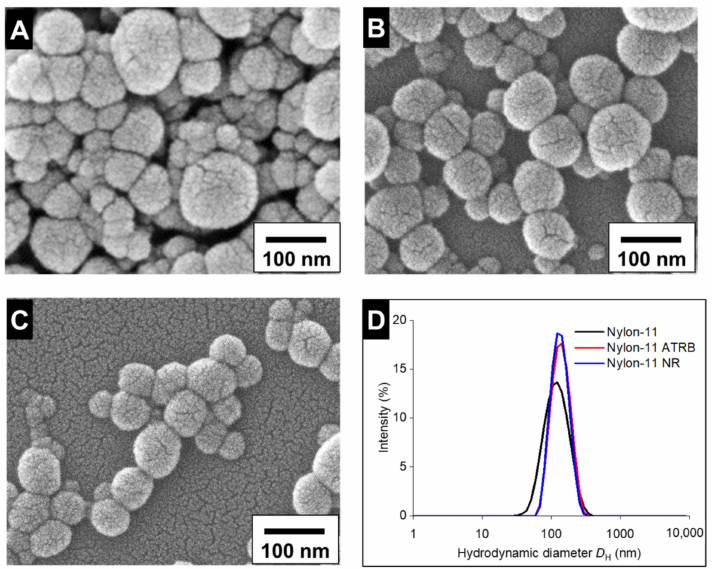
Figure 1. The SEM images for nylon-11 ( A ), nylon-11 ATRB ( B ), and nylon-11 NR ( C ) along with their corresponding DLS profiles ( D ). The DLS profile is an average of 3